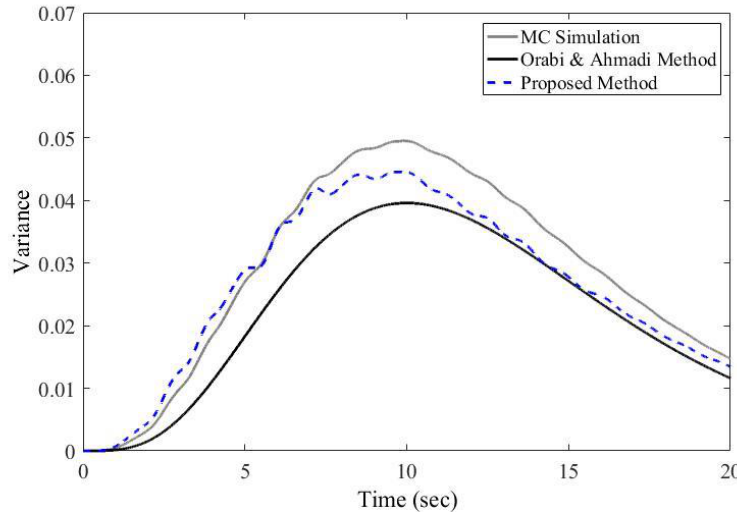
Figure 8. Mean square displacement response due to nonstationary excitation. ( γ = 10.0, μ = 1.0).